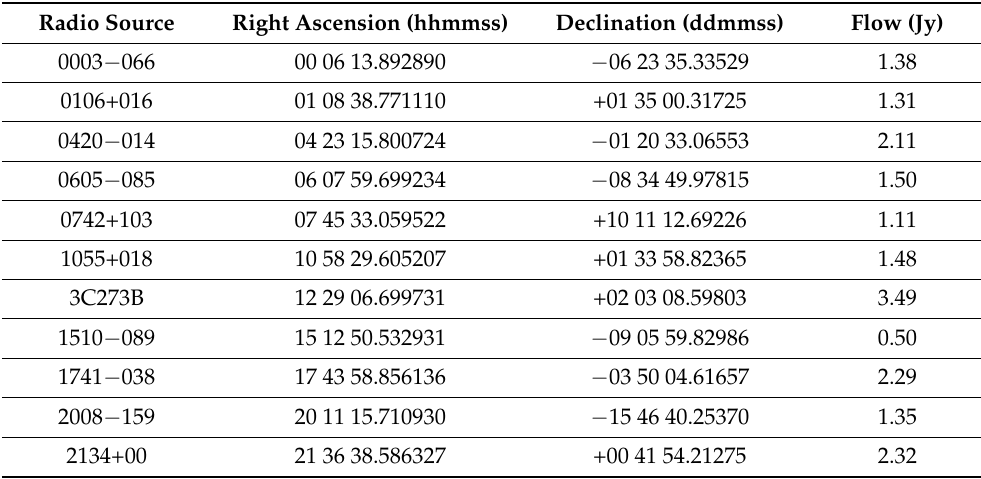
Table 3. Information on radio sources. Radio